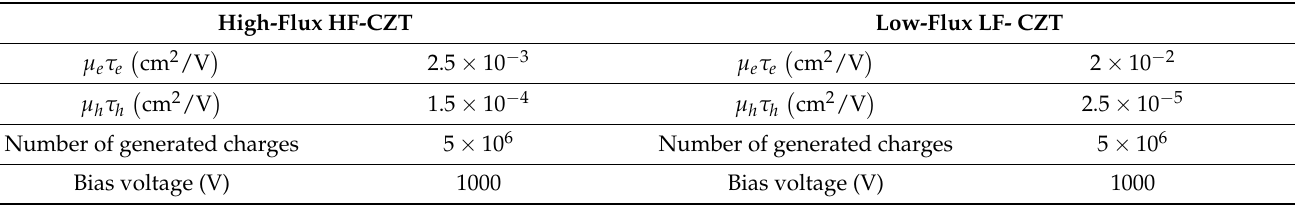
Figure 4. Measured 109 Cd and 241 Am energy spectra after the application of the charge-sharing addition (CSA) technique. The energy spectra of the single events (blue lines) and the spectra of the coincidence events with the eight adjacent pixels (multiplicity m = 2) after CSA (brown lines) for the ( a ), ( c ) LF-CZT and ( b ), ( d ) HF-CZT detectors. The energy spectra after CSA are characterized by energy deficits due to the presence of charge losses near the inter-pixel gaps, more severe for the LF-CZT detectors.